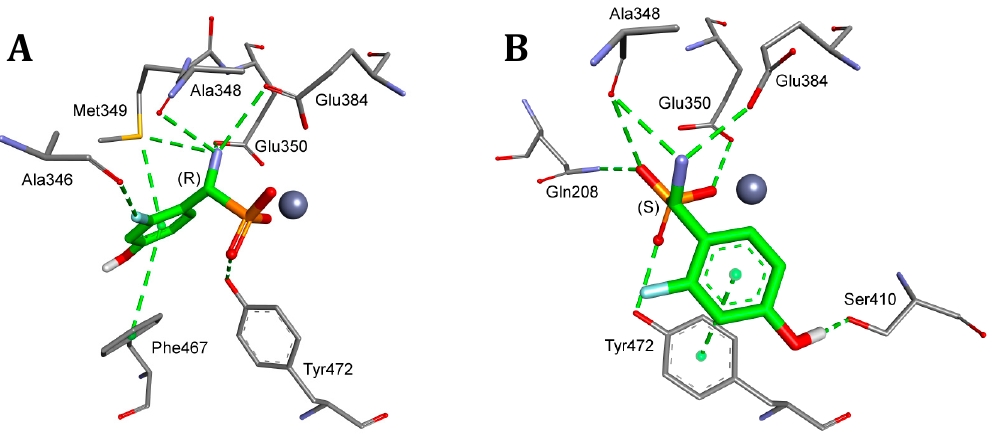
Figure 3. Mode of binding of the two enantiomers of compound 14 by porcine aminopeptidase (pAPN): A — R isomer, B — S isomer. The oxygen atom of hydroxyl is shown in red.